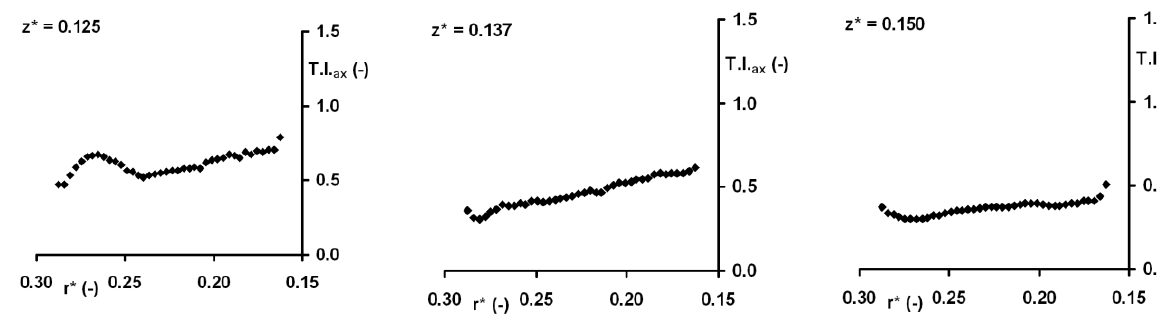
Fig. 10. Axial turbulence intensity profiles T.I. ax = f ( r * ).